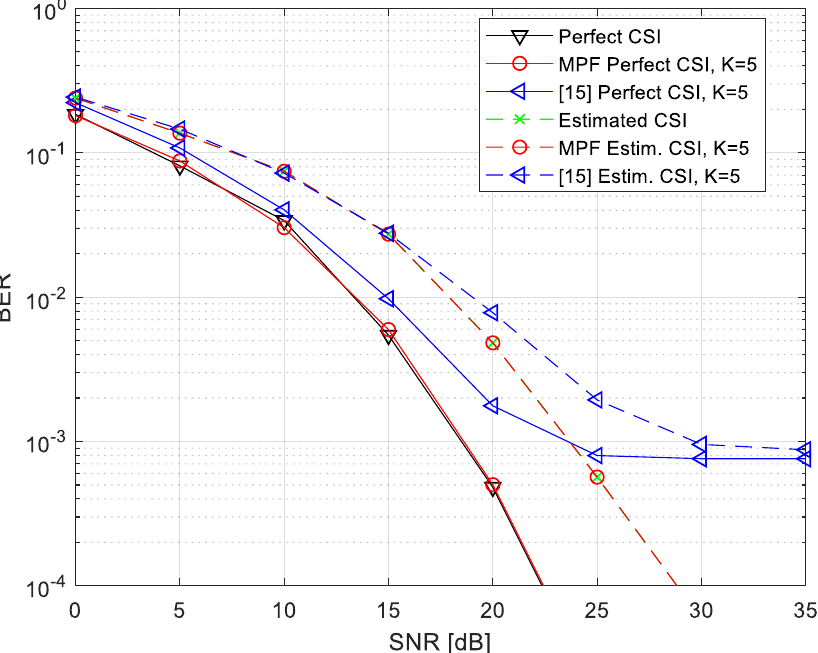
Figure 2. Performance of the equalizers [15] and the proposed 5-MPFs with quadrature phase shift keying (QPSK) modulation